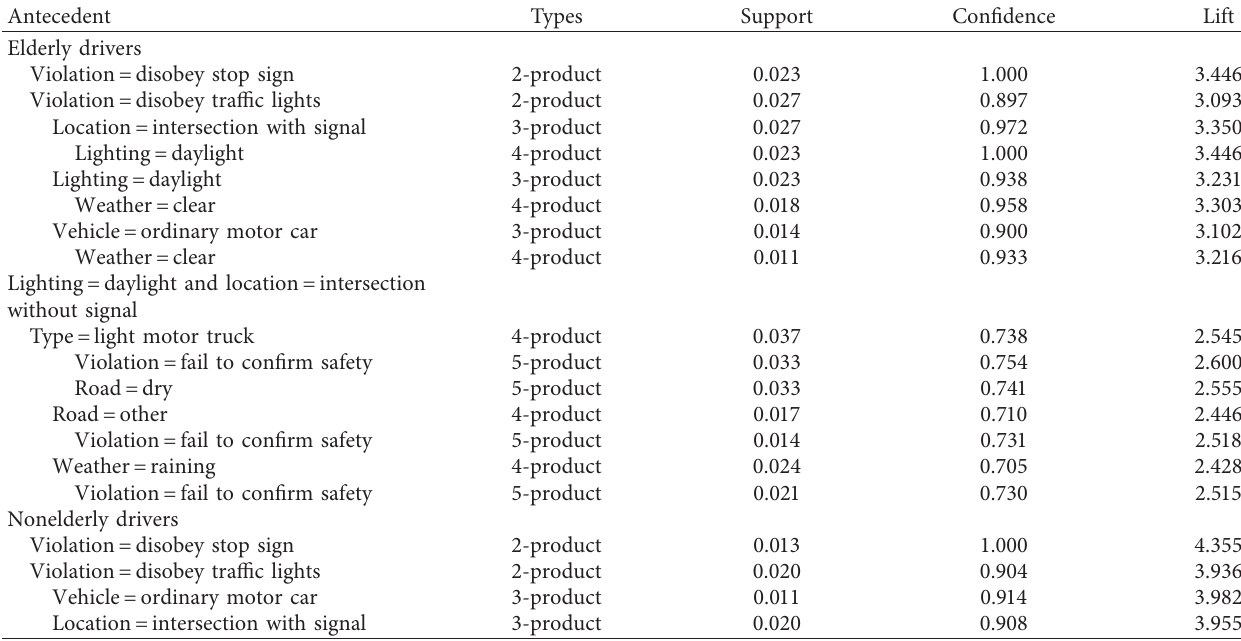
Table 2: Association rules of crossing crashes for elderly and nonelderly